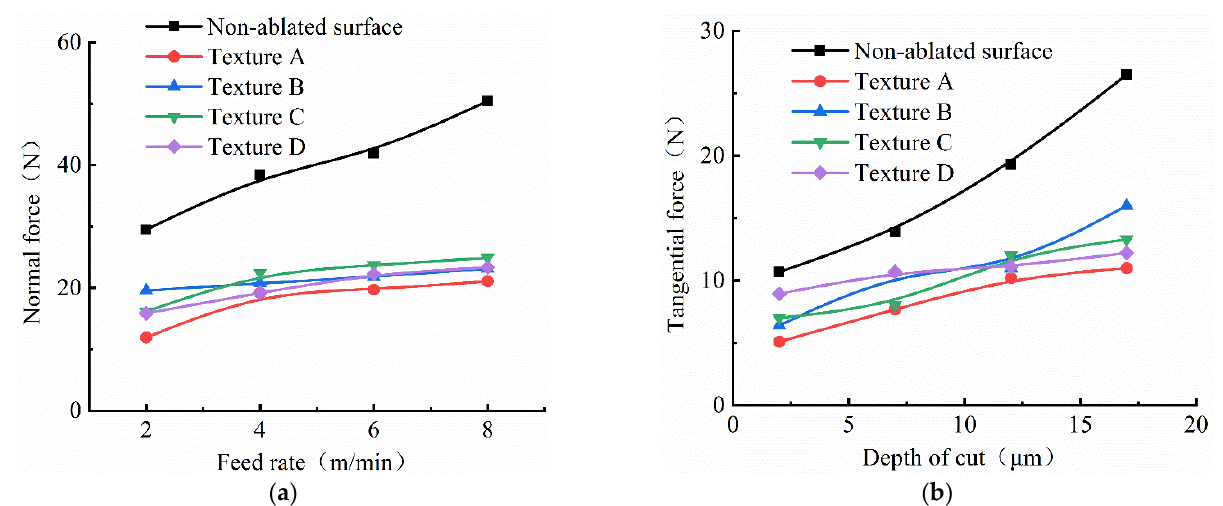
Figure 8. Influence of feed rate on grinding force with different textures; ( a ) feed rate vs. normal force; ( b ) feed rate vs. normal force.